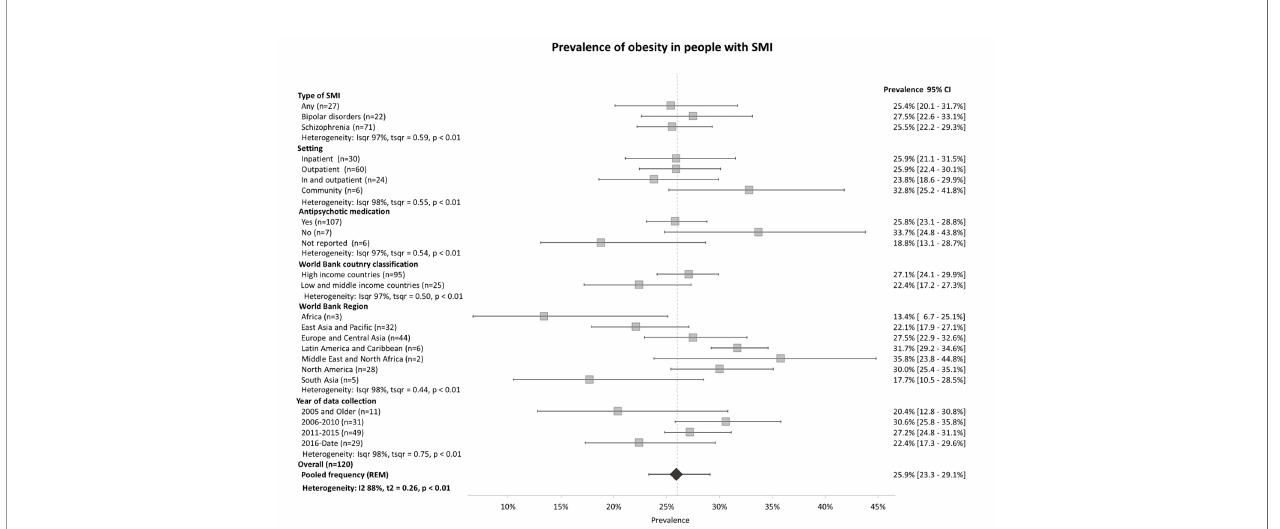
FIGURE 2 | Prevalence of obesity in people with SMI according to type of SMI, region, World Bank classi fi cation and year of data